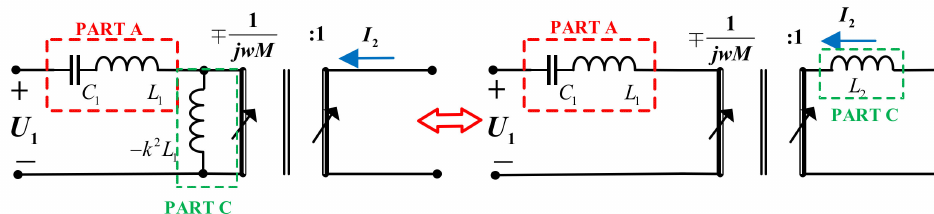
Figure 12. The equivalent model of the II_CV_CC